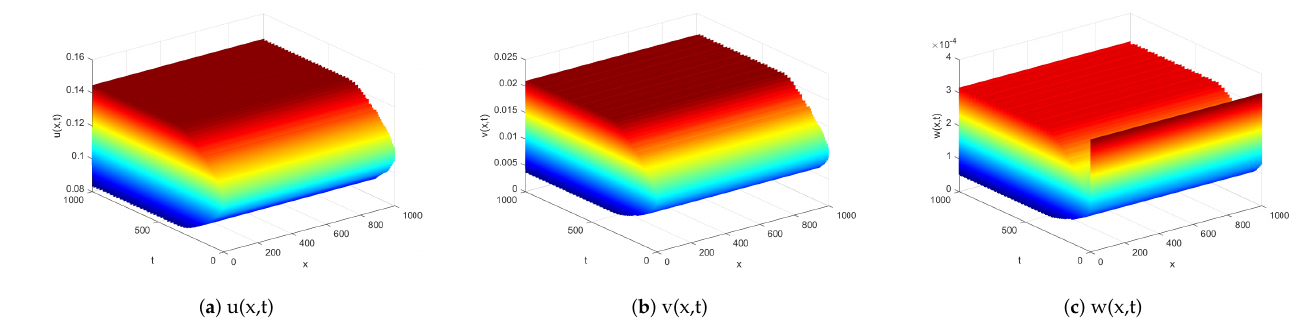
Figure 7. When d 1 = d 2 = d 3 , ( u p ( t ), v p ( t ), w p ( t )) remains stable in system